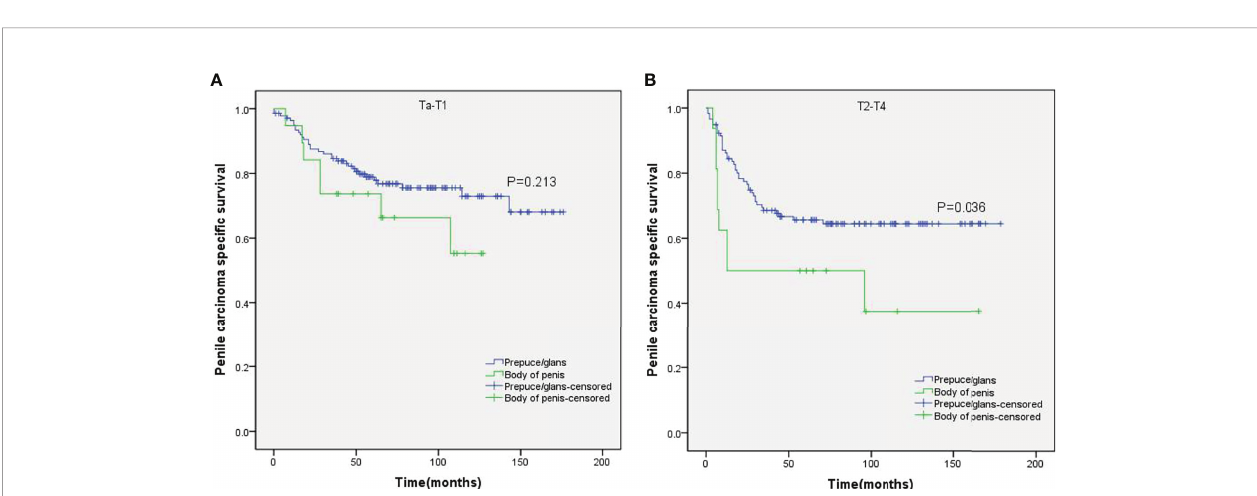
FIGURE 4 | Kaplan – Meier analyses of penile carcinoma-speci fi c survival on Ta – T1 group (A) and T2 – T4 group (B) in patients strati fi ed by tumor location.